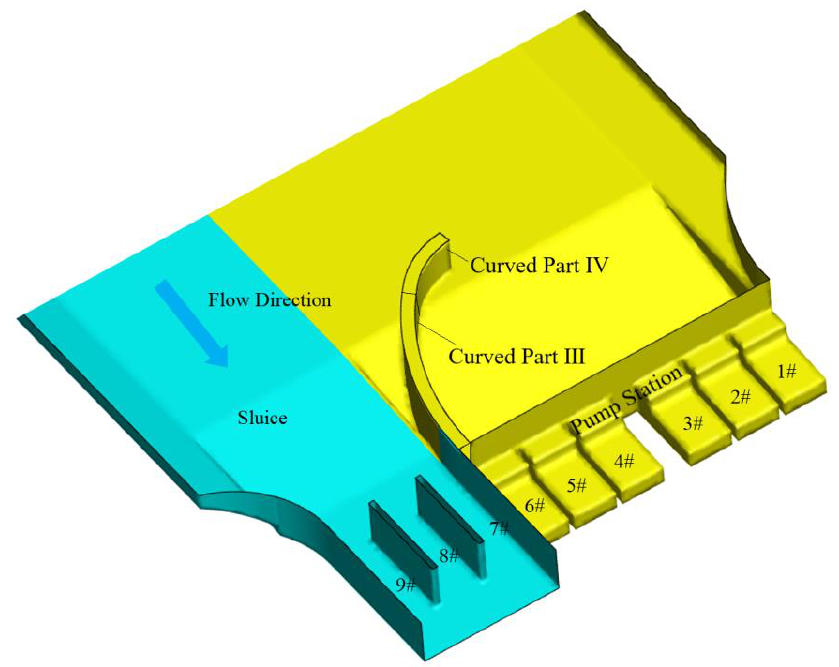
Figure 5. 3D layout of the training wall (operational state of free-draining).